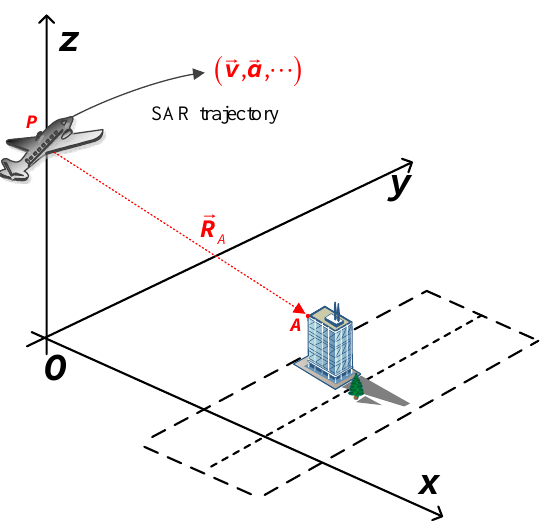
Figure 4. General geometry between SAR and the under-detected fluctuant scene.